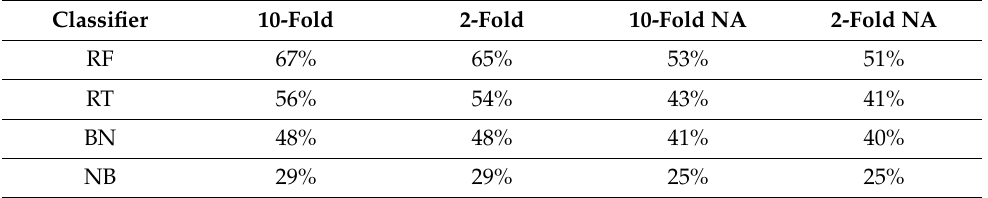
Table 3. Classifier results using 10- and 2-fold cross-validation, without normalised accelerometer values and with normalised accelerometer values